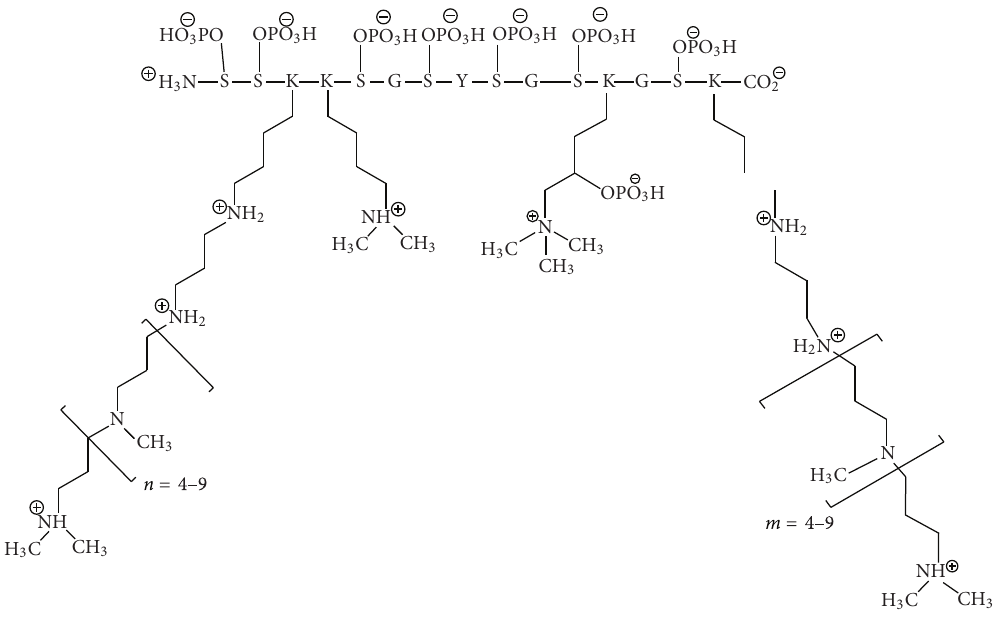
F 6: Chemical structure of silaffin-1A1. e lysine modi�cations include oligo-N-methyl-propylamine, N,N,N-trimethyl- -phospholysine. ere are 7 serine phosphorylations. Reproduced with permission from [23], adapted in turn from 𝛿𝛿